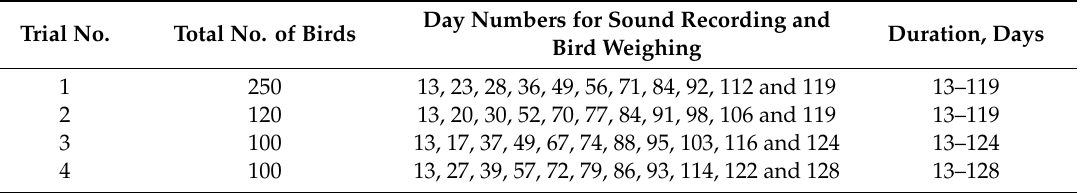
Table 1. Total number of birds monitored, day numbers (age of turkeys) for making recordings and weighing birds, and the duration of each trial. Trial No. Total No. of